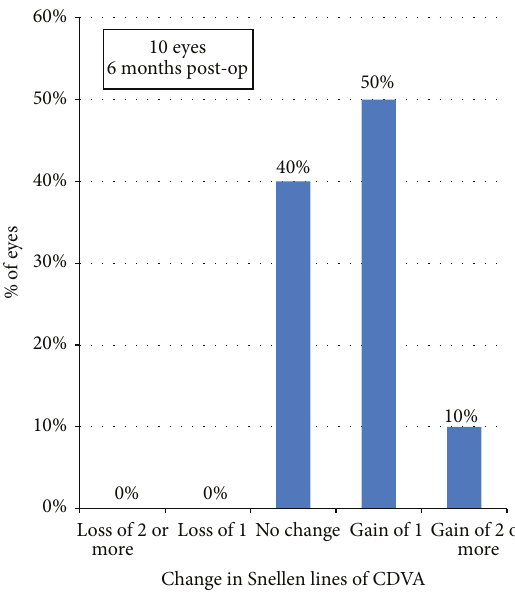
Figure 8: Change in corrected distance visual acuity 6m postoper- atively